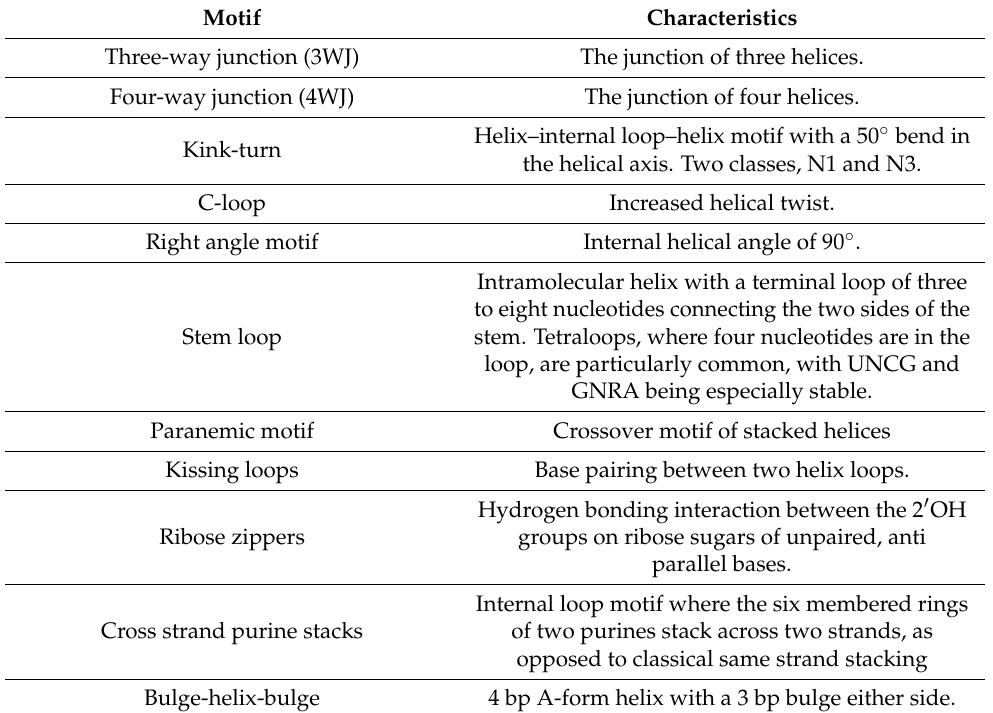
Table 1. Common RNA structure